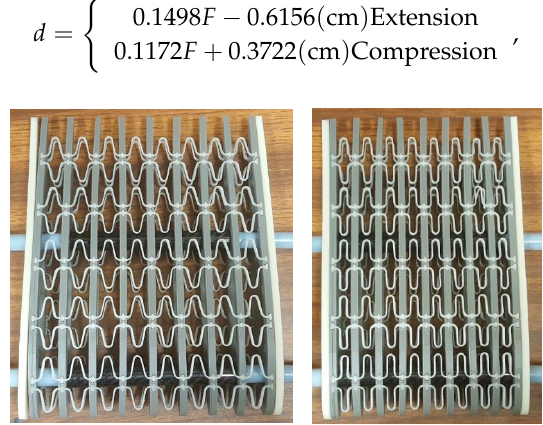
Figure 12. The span morphing partition ( left ) assembled, ( right ) under compression.